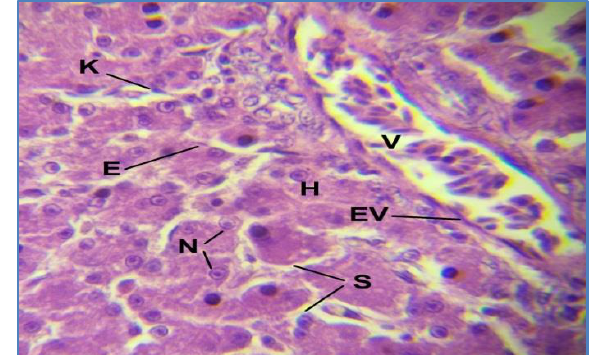
Figure, 10: Histological section of the liver in mallard duck shows, the vein (V), hepatocyte (H), sinusoids (S).nucleus of hepatocyte